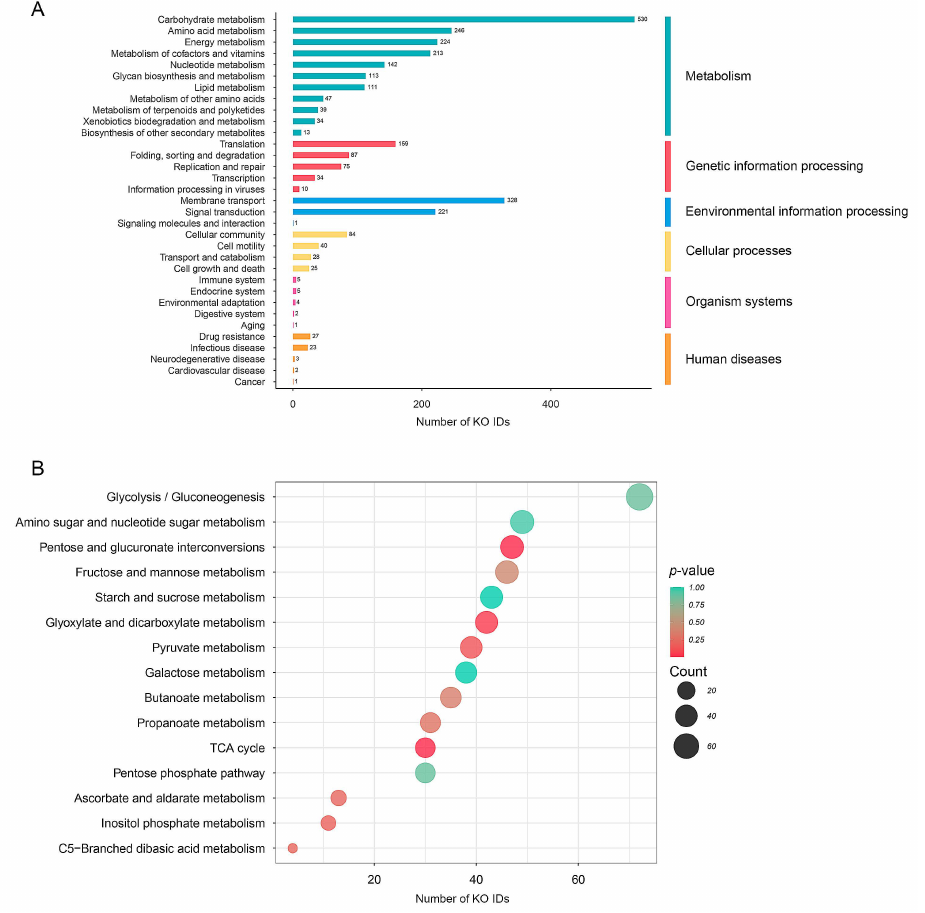
Figure 5. Functional categories underlying KO IDs from WMGS datasets of gut microbiome ( A ) Main functional categories using KEGG ( B ) Sub-metabolic categories in carbohydrate